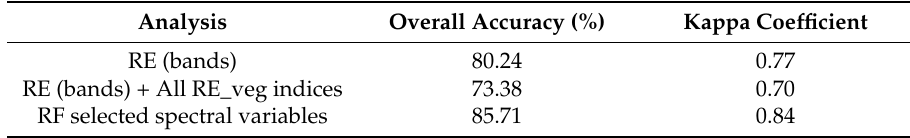
Table 4. Overall accuracies and kappa coefficient of agreement for the two maize mono- and mixed cropping